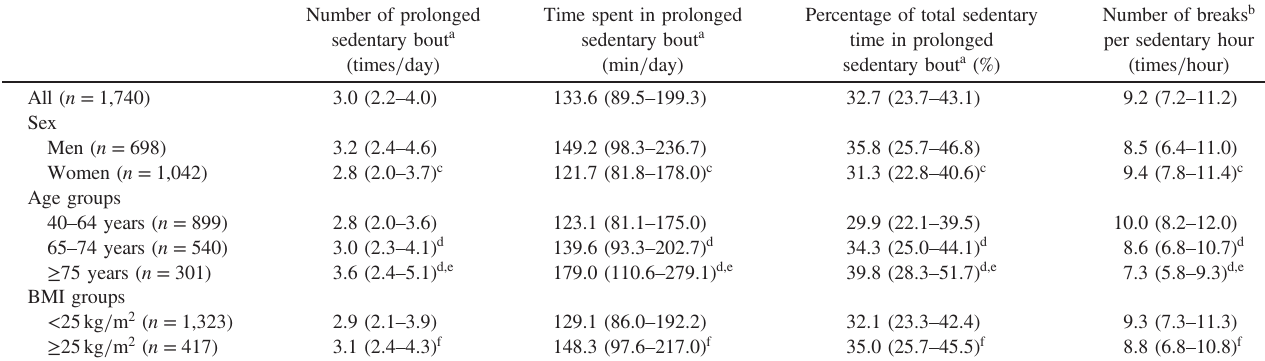
Table 2. Patterns of tri-axial accelerometer-measured sedentary time by sex, age, and BMI